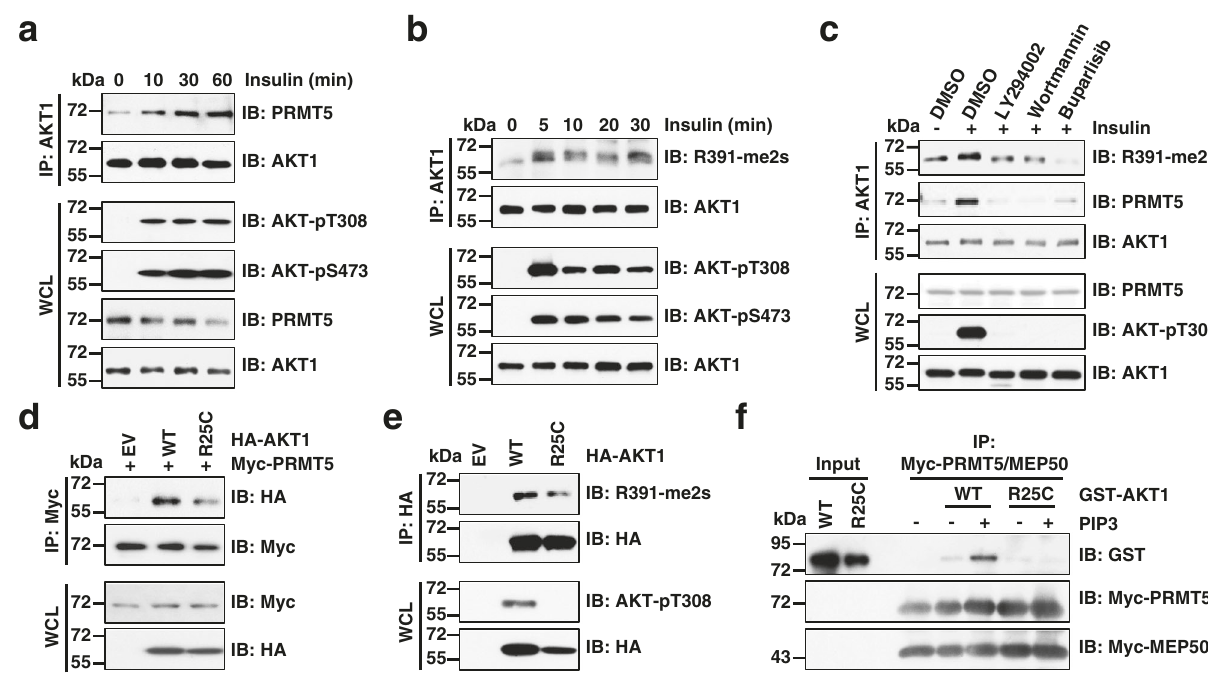
Fig. 4 PI3K signaling enhances AKT1-R391 dimethylation. a , b IB analysis of WCLs and IP products derived from MCF7 cells. The cells were serum- starved for 16 h and then treated with 100 nM insulin for indicated time periods before collection. c IB analysis of WCLs and IP products derived from MCF7 cells. The cells were serum-starved for 24 h and treated with PI3K inhibitors for 12 h followed by insulin for 30 min before collection. LY294002 (20 μ M), Wortmannin (10 μ M), and Buparlisib (10 μ M). d , e IB analysis of WCLs and IP products derived from HEK293T cells transfected with indicated constructs. f In vitro binding assays were performed with recombinant GST-AKT1 protein puri fi ed from mammalian cells and Myc beads bound with PRMT5/MEP50. The binding was performed at 4 °C for 4 h incubated with or without PIP3 (20 μ M) and subjected to IB analysis. Similar results were obtained in n ≥